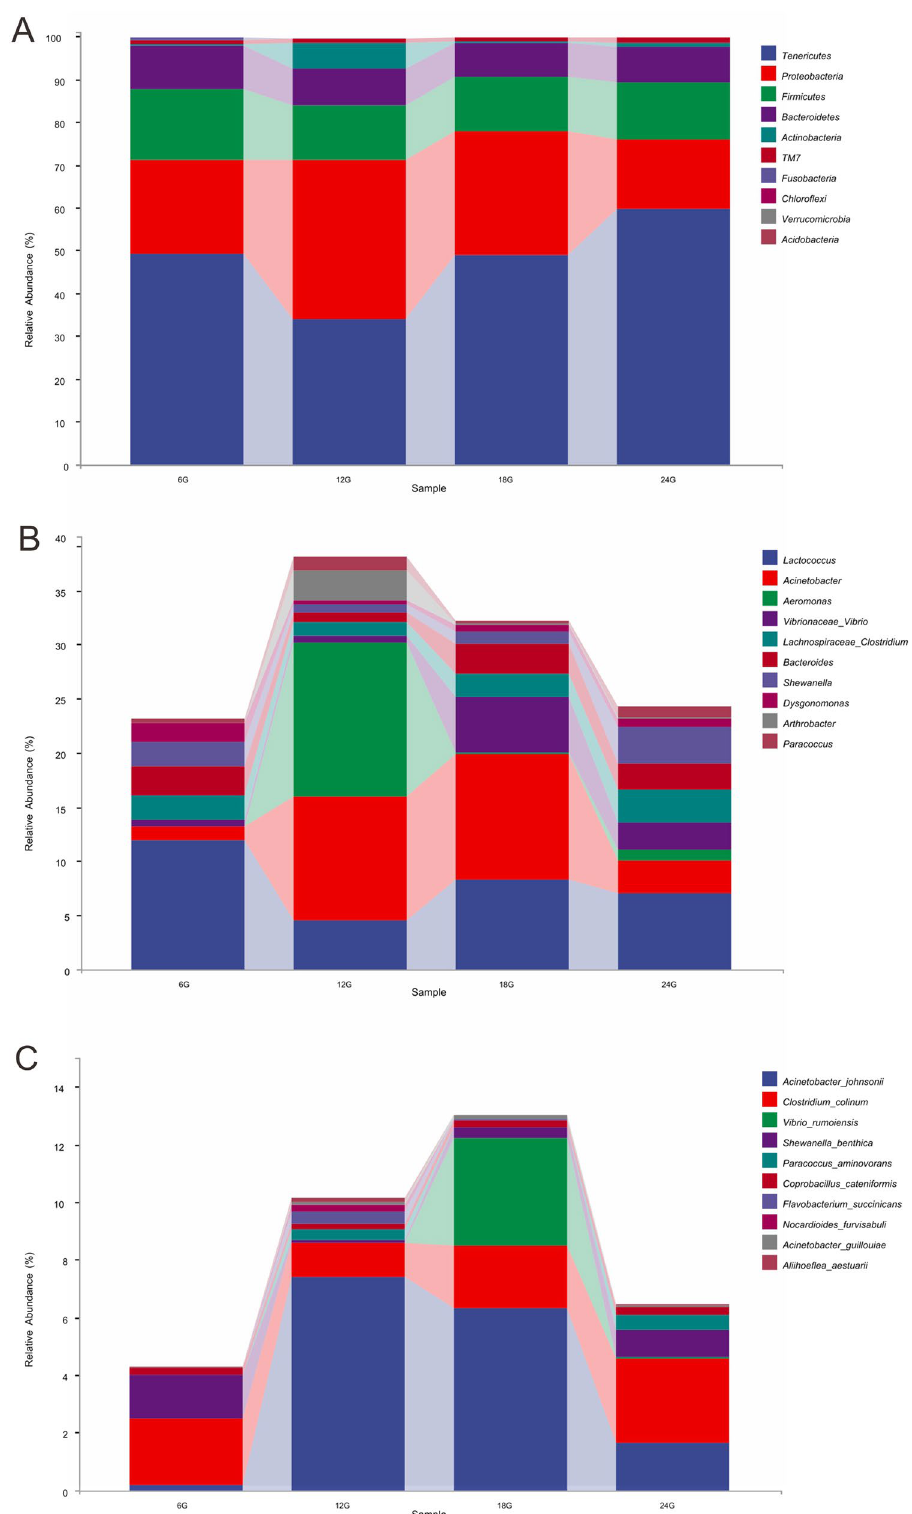
Figure 1. Relative abundance of gut microbial communities in Eriocheir sinensis at different feeding times at the phylum level ( A ), genera level ( B ), and species level ( C